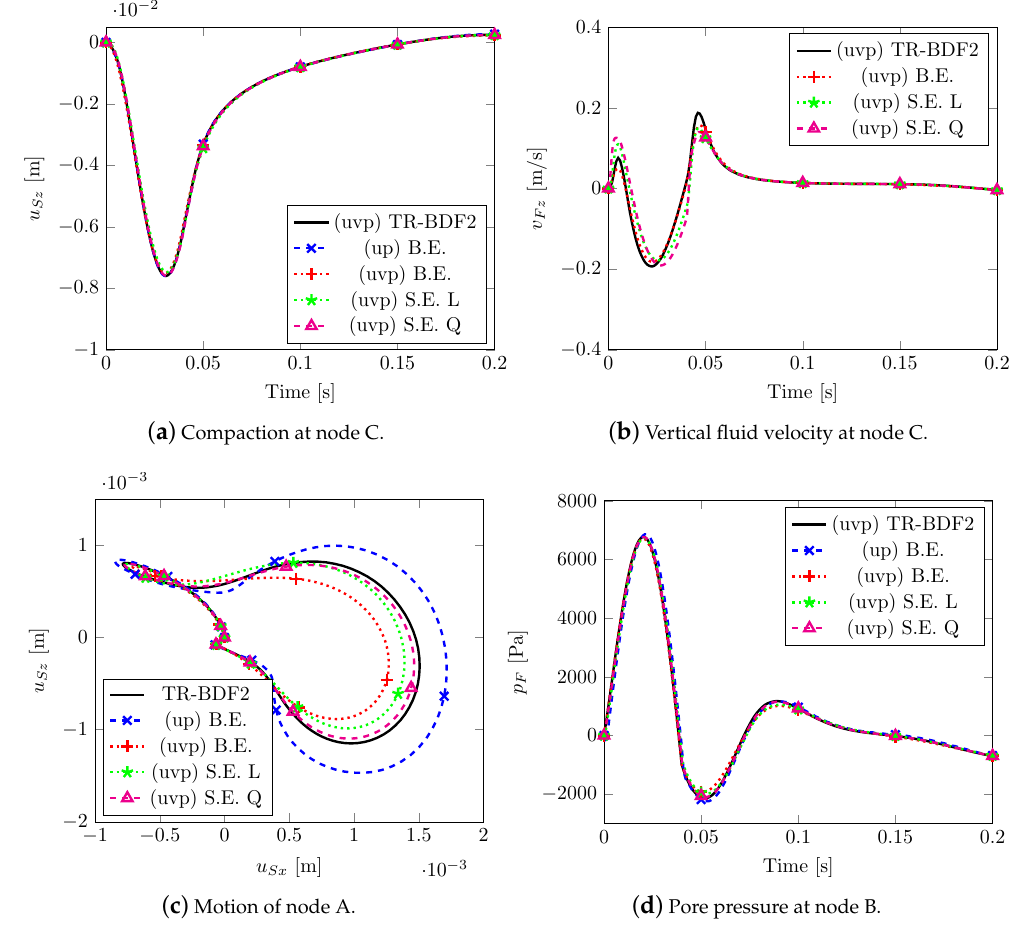
Figure 5. Solutions 2D wave